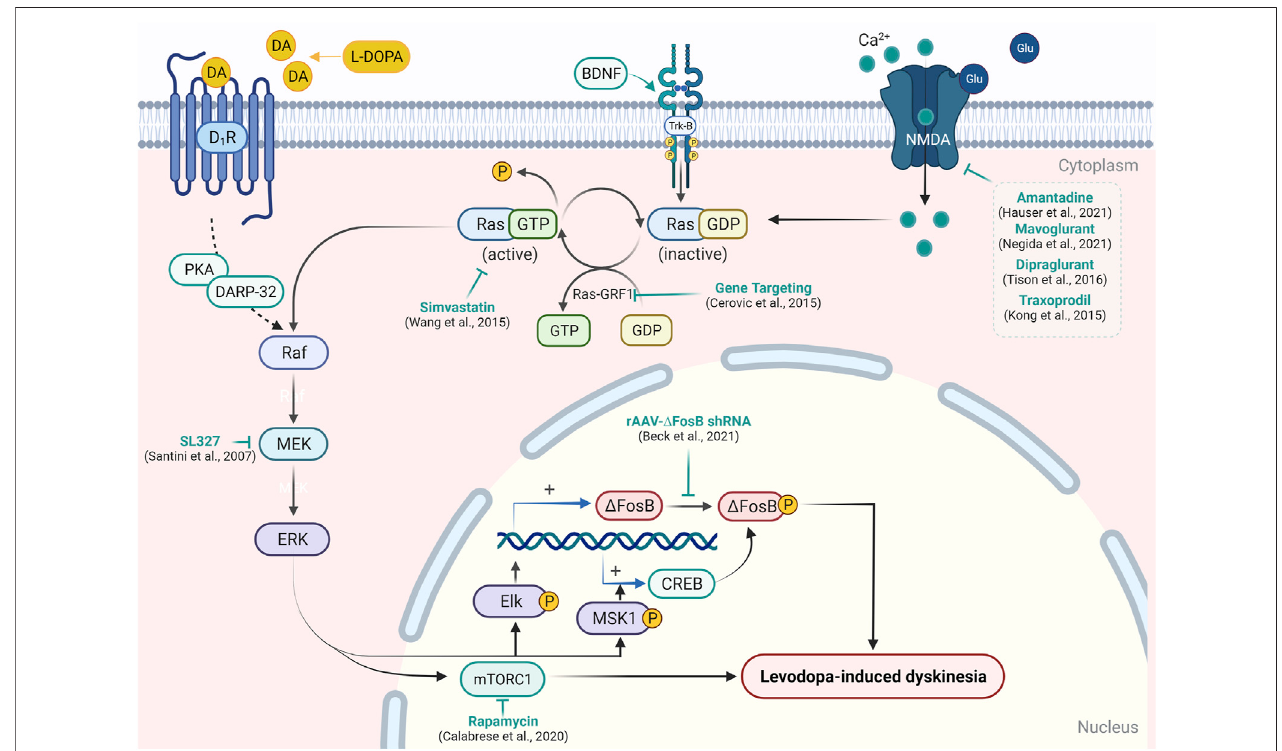
FIGURE2| Targeting signaling upstream/downstream ofRas/Raf/MEK/ERK pathway modulation inLID.In theexperimental modelofPD, L-DOPA administration causes abnormal activation of the RAS/RAF/ERK pathway and results in the emergence of dyskinetic behavior. Activation of D1R, Trk-B, or NMDA receptor causes activation of RAS-GDP molecular switch by Ras-guanyl nucleotide-releasing factor 1 (Ras-GRF1), which facilitates the conversion of RAS-GTP to Ras-GDP. Ras-GDP further causes the activation of Raf protein kinase, which in turn leads to the phosphorylation of mitogen-activated protein kinase/ERK kinase (MEK) and ERK. Activation of ERK enhances expression of the transcription factor Δ FosB- and ERK-dependent activation of mTORC1, which results in the inhibition of long-term depression in striatal neurons and development of the abnormal involuntary movement in PD patients. Attenuation of Ras-GRF1 in the knock-out mice model results in the attenuation ofLID. Asimilar reductionin LID wasresulted inthe inhibition of Ras(by simvastatin) and MEK (by SL327) expression. On theotherhand,the inhibition of Δ FosB by short hairpin RNA and blockade of mTORC1 by rapamycin has been shown to mitigate LID. Various NMDA receptor antagonists have also been reported to reduce the expression of the Ras/Raf pathway and support their ef fi cacy in